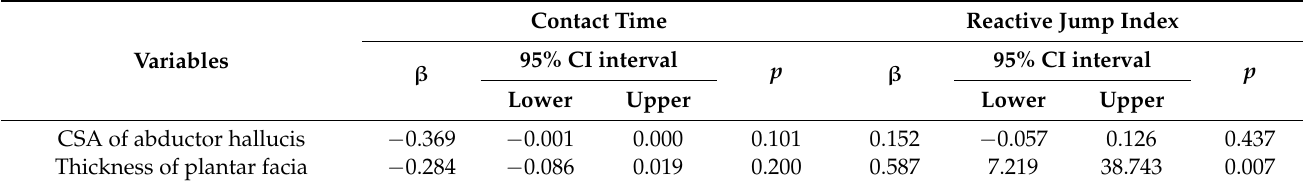
Table 3. Multiple Regression Analysis of the Association between Ultrasound Assessment and Repetitive Rebound Jump.